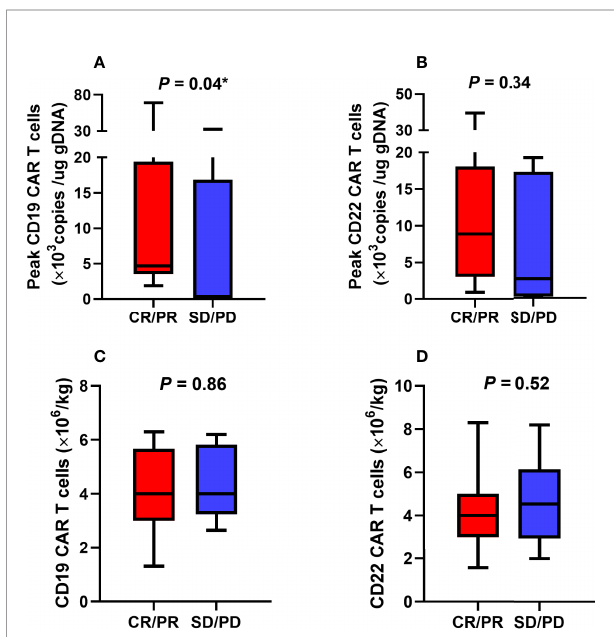
FIGURE 5 | Association between CAR T cells and objective response. (A) The poor expansion of CD19 CAR T cells in vivo was associated with unsatisfactory ef fi cacy. (B-D) There were no statistically signi fi cant correlations between CD22 CAR T cells expansion levels, CAR T cell infusion doses, and objective response. CAR, chimeric antigen receptor; CR, complete response; PD, progression of disease; PR, partial response; SD, stable disease. *The comparison was considered statistically signi fi